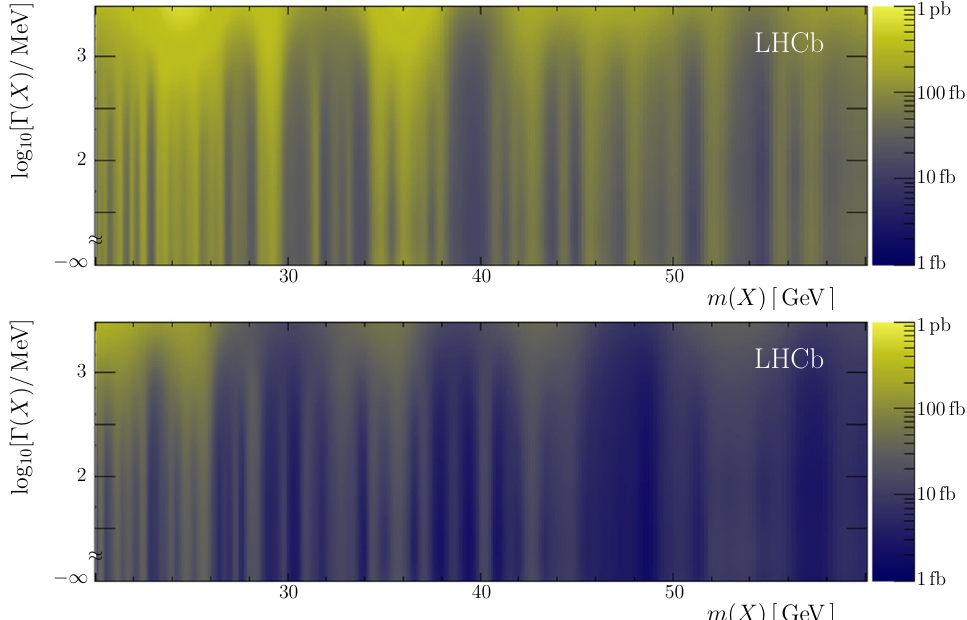
Figure 8 . Upper limits at 90% con(cid:12)dence level on the cross section (cid:27) ( X m ( X ) > 20 GeV region for the (top) inclusive and (bottom) associated beauty searches for prompt X (cid:22) + (cid:22) (cid:0) decays. !